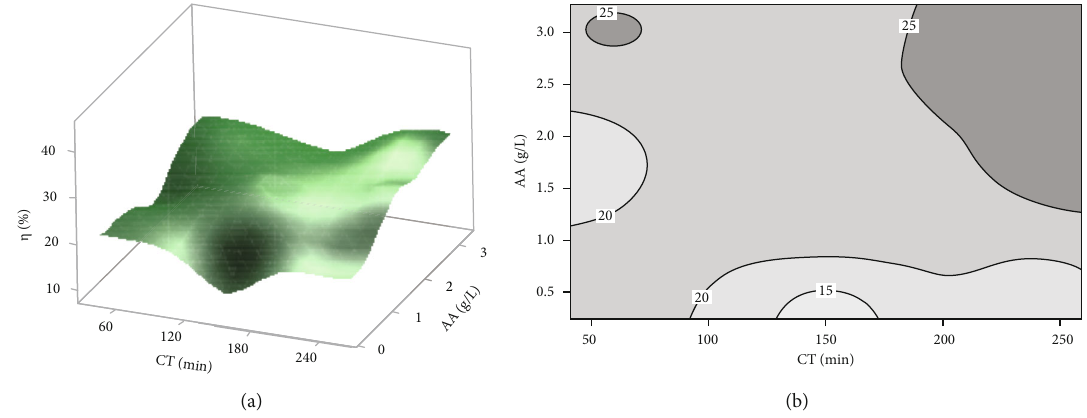
Figure 8: (a) Three-dimensional response surface displaying the e ff ects of CT and AA on the process e ffi ciency. (b) Two-dimensional contour plot showing the e ff ects of CT and AA on the process e ffi